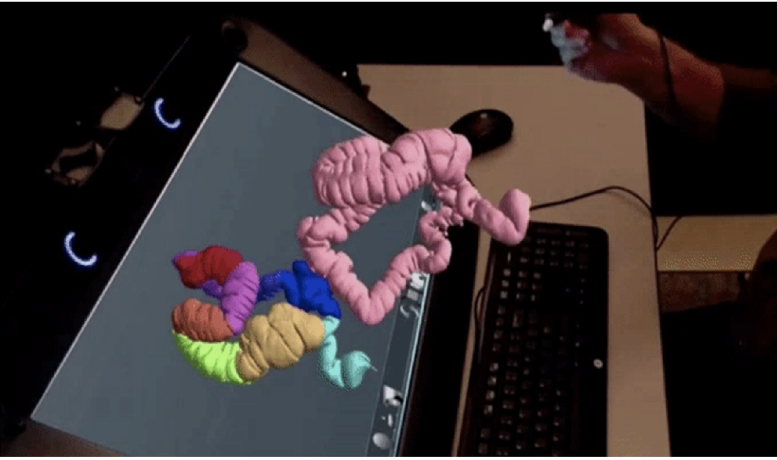
(EchoPixel, Mountain View, CA, USA). This is the first holographic imaging viewer approved by the FDA as a tool for diagnosis as well as surgical planning. A stylet can interact with the displayed volume of the colon, providing an accurate three-dimensional representation of patient